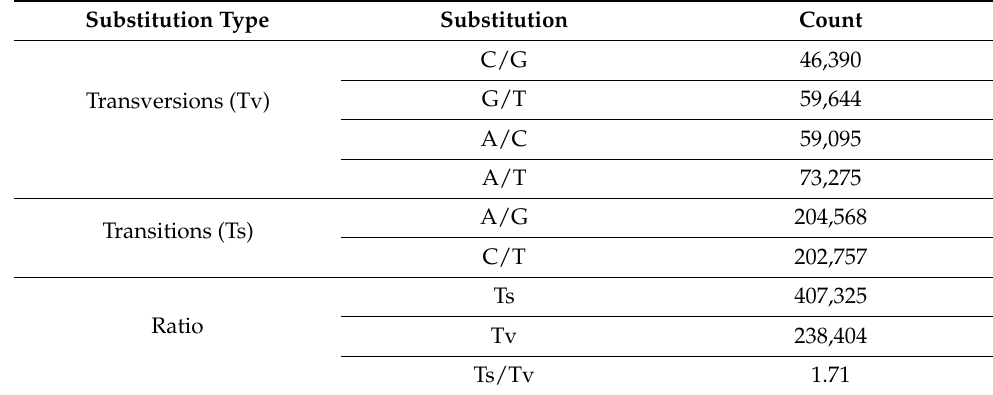
Table 4. Number of transitions and transversions based on the SNPs identified in 82 lines of Phaseolus species based on the reference genome of Phaseolus vulgaris .